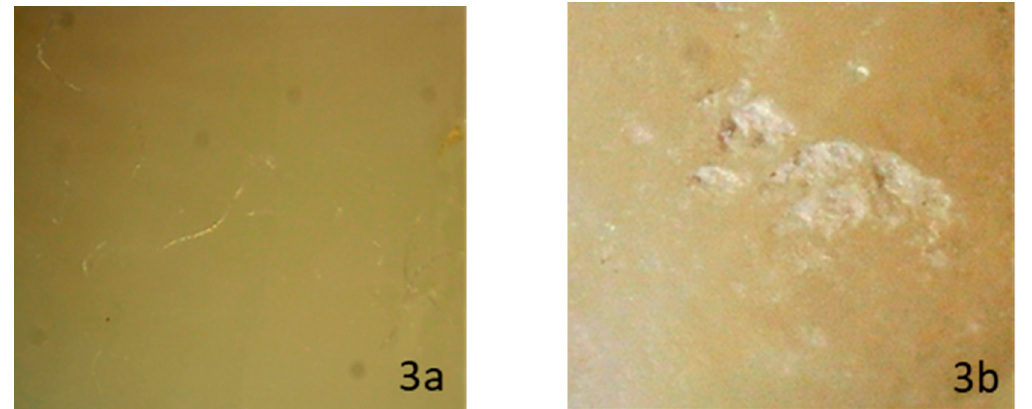
Figure 2. Stereomicroscopic evaluation showing formation of enamel microcracks after laser debonding ( 2b ) from a previously sound enamel surface ( 2a ).